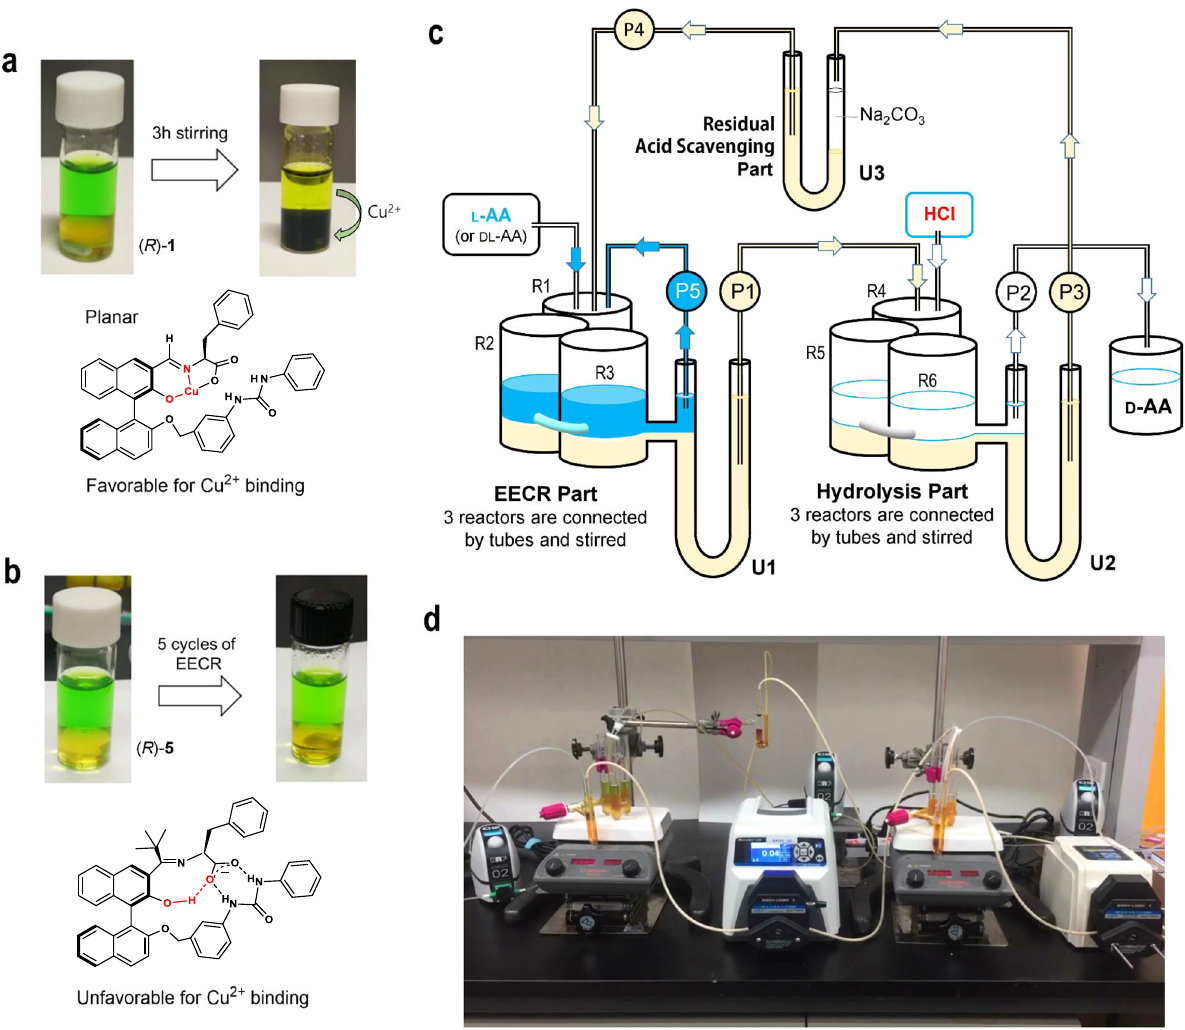
Fig. 4 Cu 2 + sequestration and EECR in continuous fl ow. a When ( R )- 1 was used as the extractant, a striking color change indicating the transfer of Cu(II) from the aqueous to the organic layer was observed. b When ( R )- 5 was used as the extractant, the color did not change over fi ve EECR cycles. c Schematic design of continuous reaction system (CRS) that carries out EECR and hydrolysis reactions repeatedly. d Photographs of CRS in operation on the lab bench. The apparatus was manufactured to accommodate a total solution volume of 100